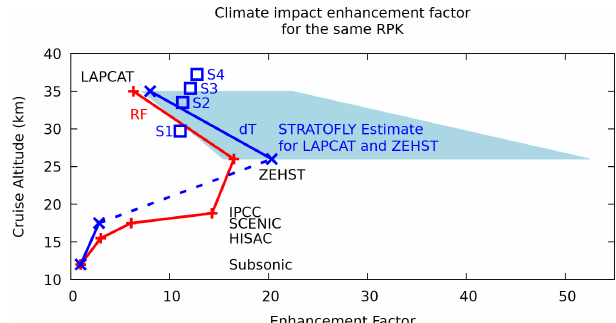
Figure 11. Radiative forcing (red) of a fleet of the respective air- craft 50 years after entry into service (EIS) and the near-surface temperature change (blue) based on the HIKARI project results. RPK (unit pax-km) refers to the revenue passenger kilometers, i.e., total kilometers traveled by all passengers on an aircraft or on a fleet of aircraft. The shaded area shows an uncertainty range from this work. This figure is taken from Grewe (2021) and includes the values of four STRATOFLY MR3 versions for different altitudes (S1 to S4) based on data published by Viola et al. (2021a, Table